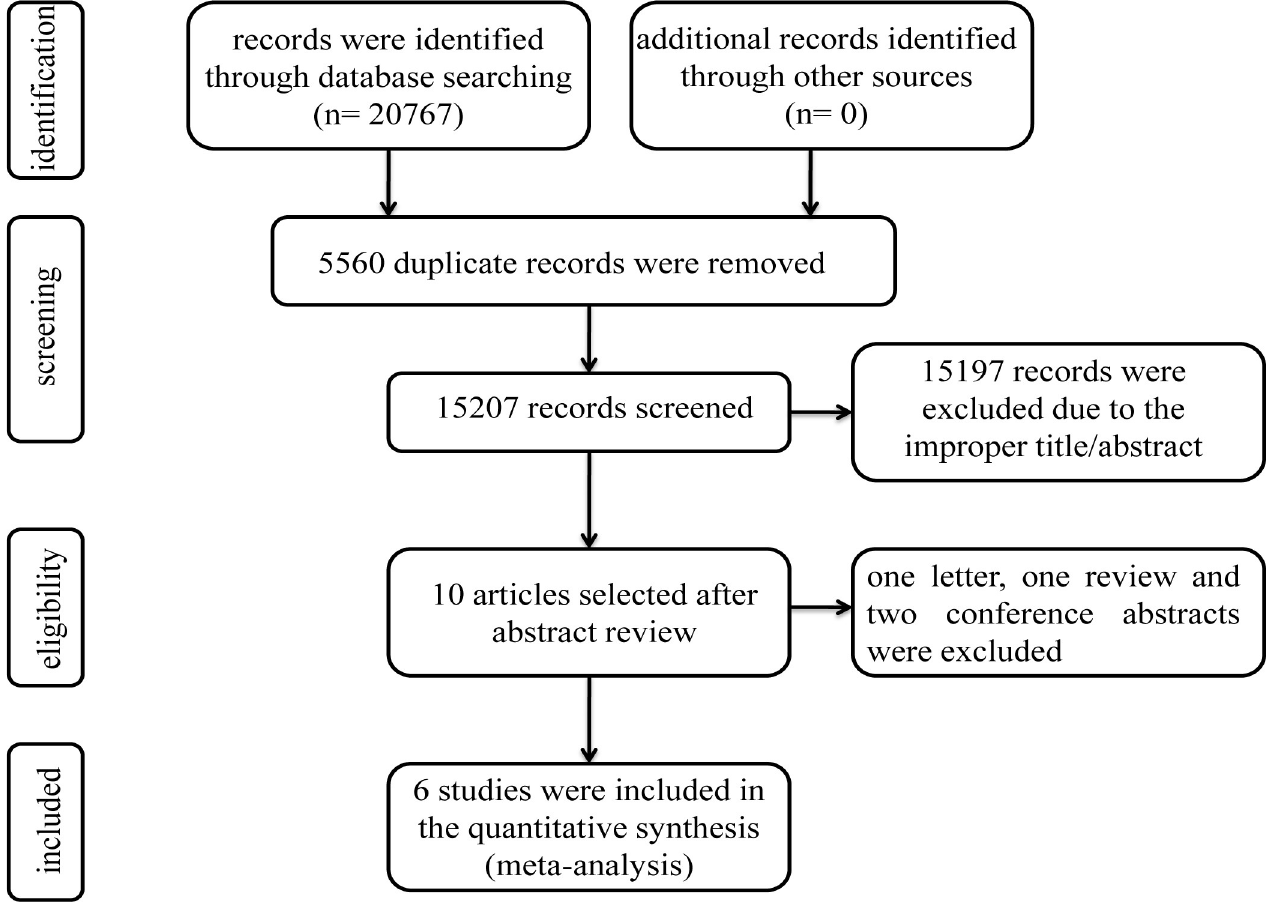
Fig 1. Flow chart of literature